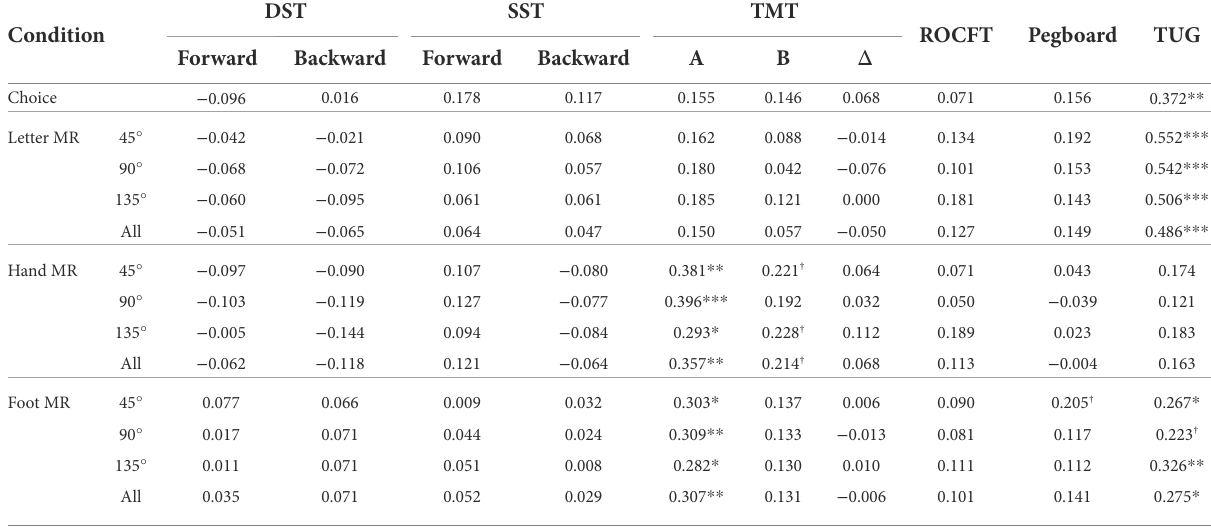
TABLE 3 Spearman’s partial correlation coefficients of experimental measures (choice RT and Δ RT of the MR task) with neuropsychological and motor performance in the older group ( n = 71; but one did not perform TUG). DST Condition